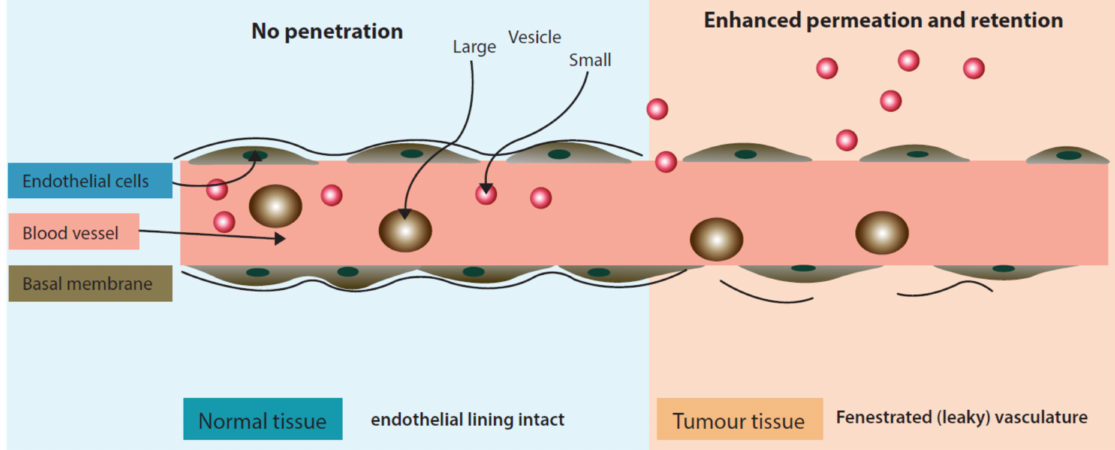
Figure 3. ‘Enhanced Permeation and Retention’ effect exhibiting enhanced permeability of liposomes in inter-tumoral